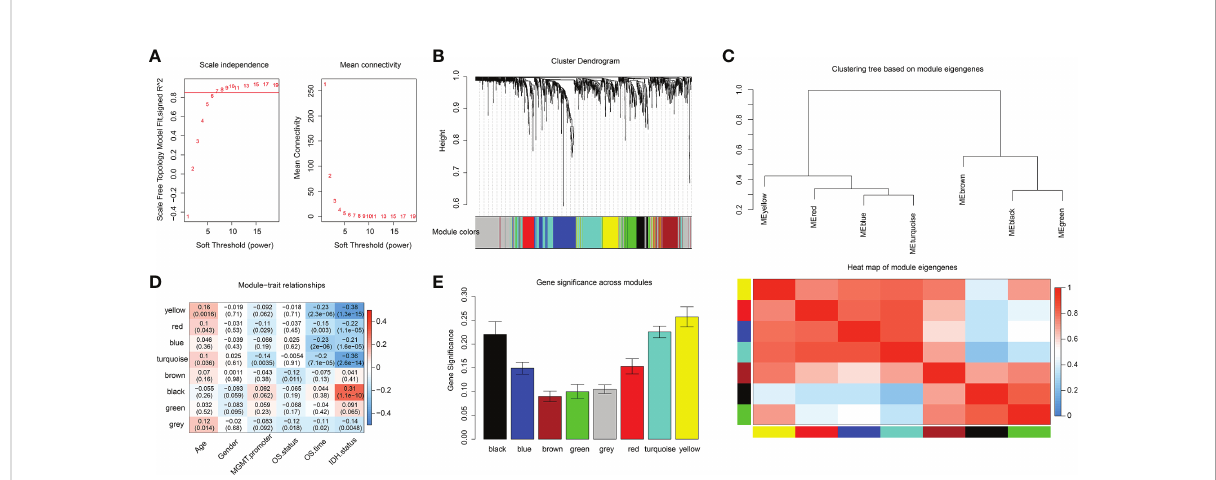
FIGURE 3 Identi fi cation of key modules associated with clinical traits of GBM based on the TCGA database by WGCNA. (A) Analysis of network topology for various soft-thresholding powers. (B) Clustering dendrograms of genes, with dissimilarities based on topological overlap, with assigned module colors. (C) The module eigengenes adjacency presented by hierarchical clustering (upper panel) and heat map (lower panel). The gene expression level of each module was represented with module eigengenes. (D) Module-trait relationships. Each row represents a module eigengene, each column corresponds to a clinical trait of GBM. The corresponding correlation coef fi cient and p-value are shown in each cell. (E) Distribution of average gene signi fi cance in the modules associated with IDH status of GBM.